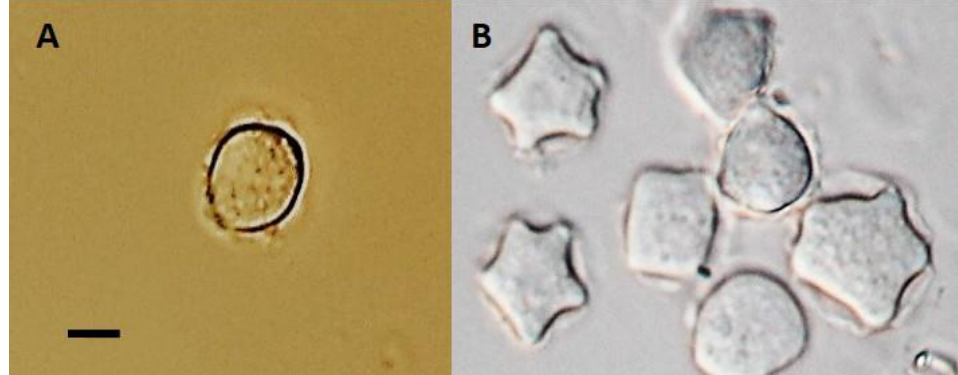
Figure 2. Light microscopy photographs of trophozoite ( A ) and cyst ( B) stages of Atacama free-living